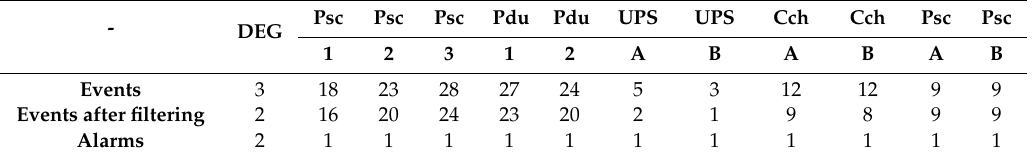
Table 3. Comparison of the alert / event number (without root cause method (RCM))—data center power supply level.